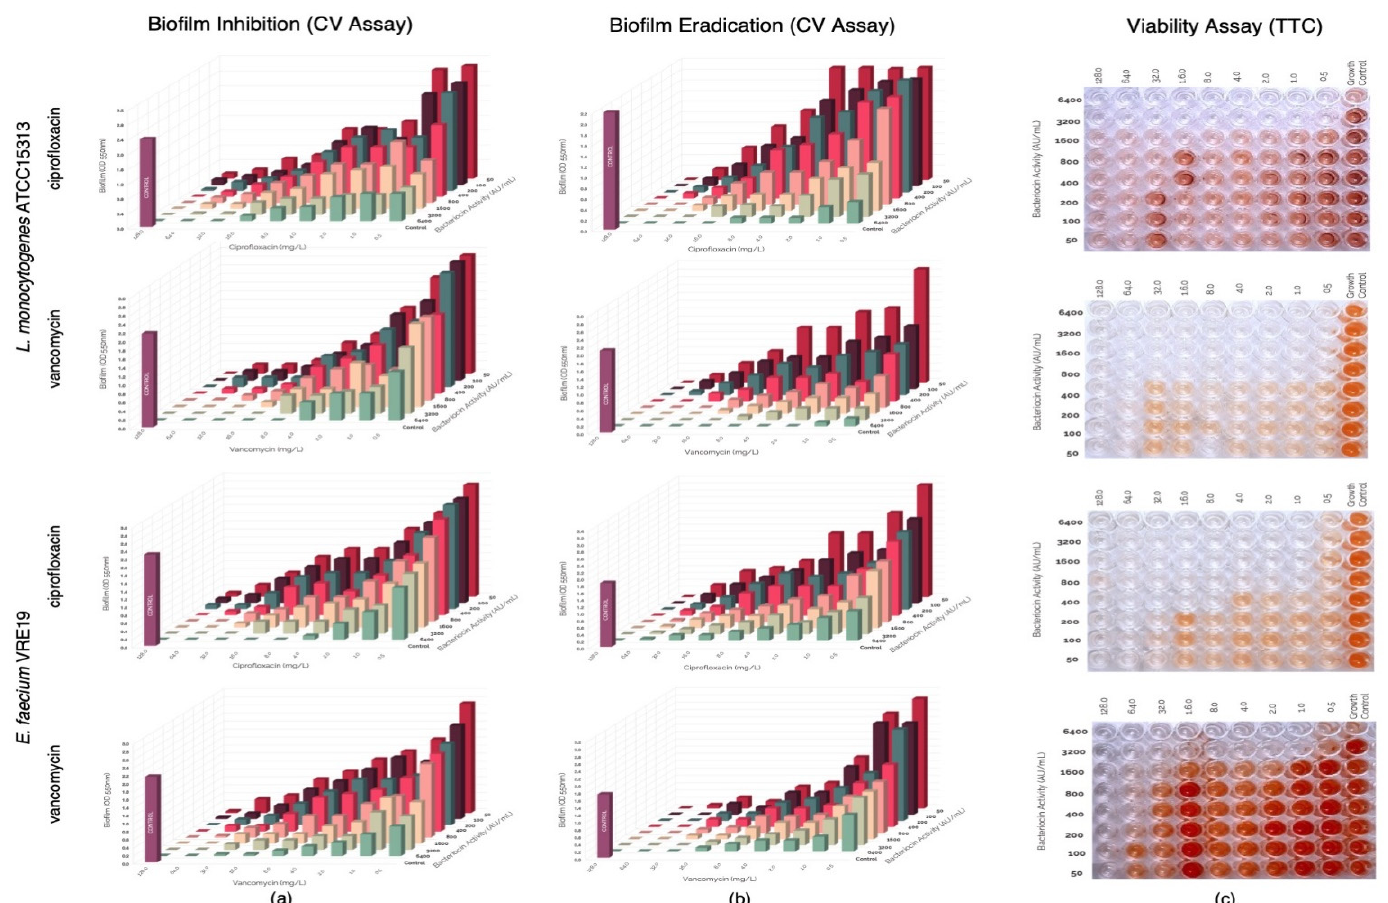
Figure 5. Evaluation of synergy between semi-purified bacteriocin ST7319ea and antibiotics (ciprofloxacin or vancomycin) on the ( a ) biofilm formation and ( b ) biofilm eradication of Listeria monocytogenes ATCC15313 and Enterococcus faecium VRE19 as demonstrated on the topographic analysis biofilms by crystal violet assay; and ( c ) confirmation of cell viability were carried out using TTC assay.